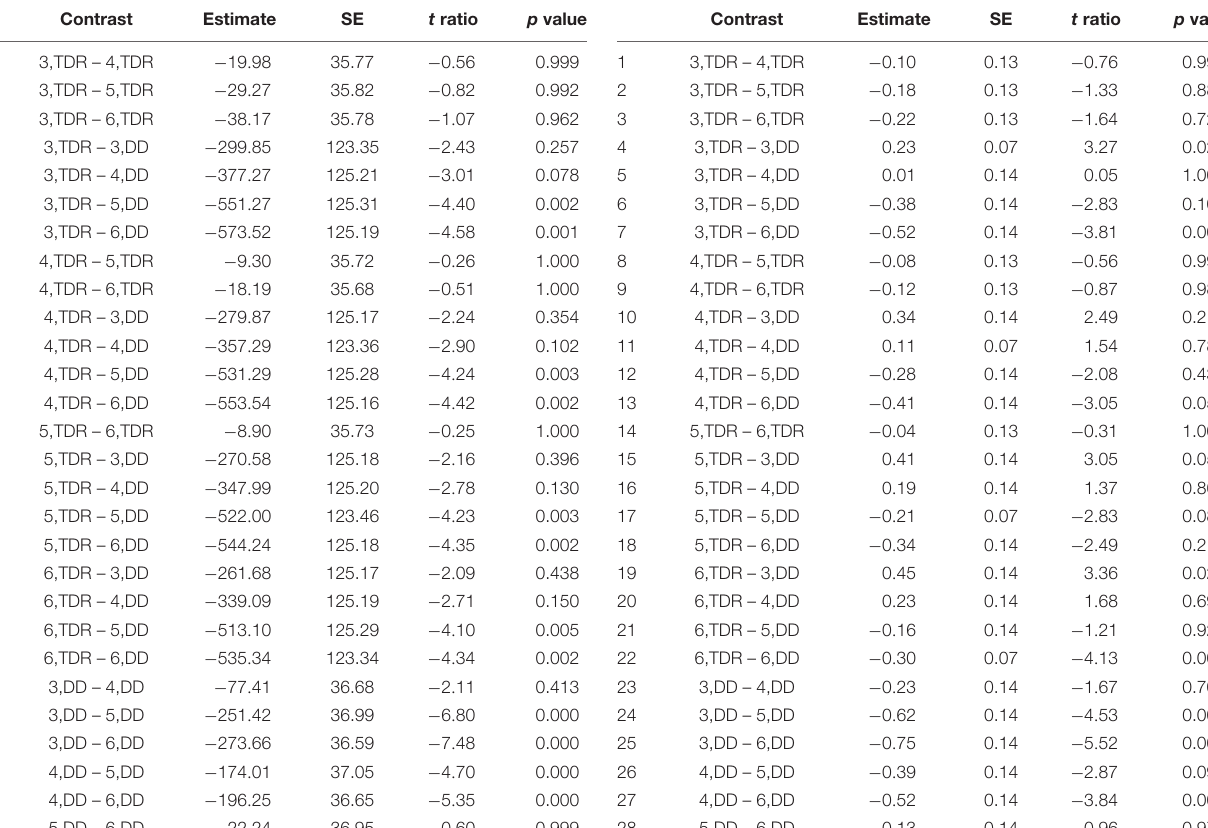
TABLE 4 | Non-words post hoc comparisons on the raw data using Tukey correction.